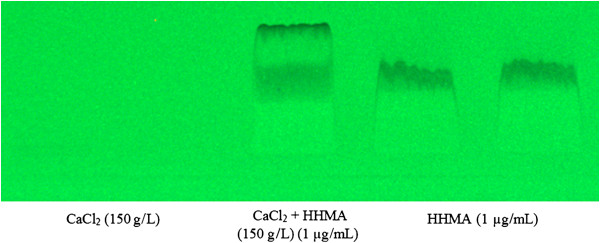
The HPTLC chromatogram of HHMA (1 μg/mL) in water and in the presence of CaCl2 (150 g/L).